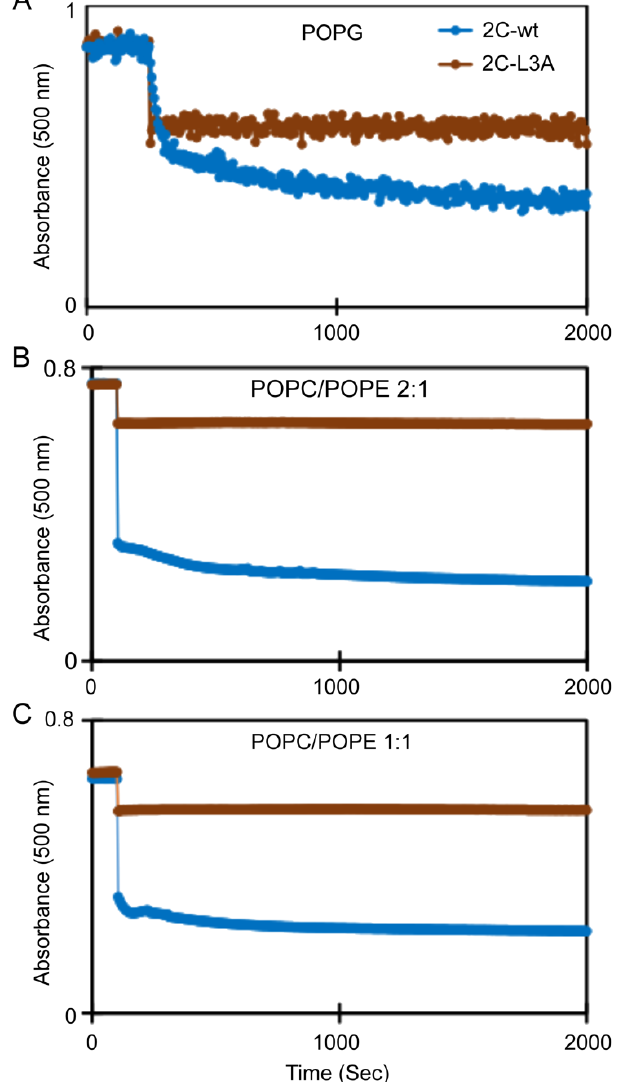
Figure 2. Clearance of lipid vesicles by 2C peptides. ( A ) POPG vesicles; ( B ) POPC / POPE 2:1 vesicles; ( C ) POPC / POPE 1:1 vesicles. The molar ratio of protein / lipid was 1:10.